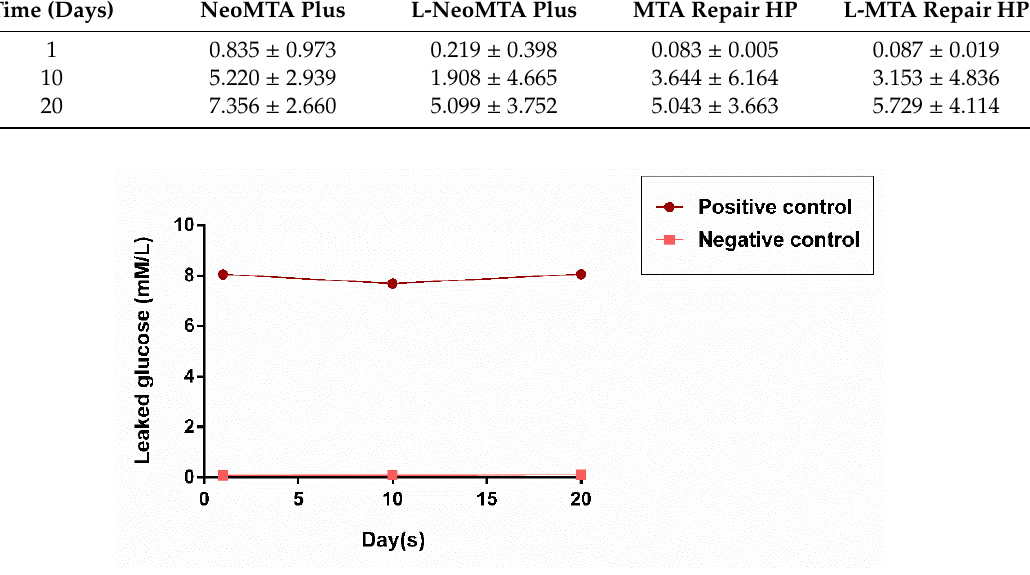
Figure 4. Mean glucose concentrations in control groups throughout the experimental period.